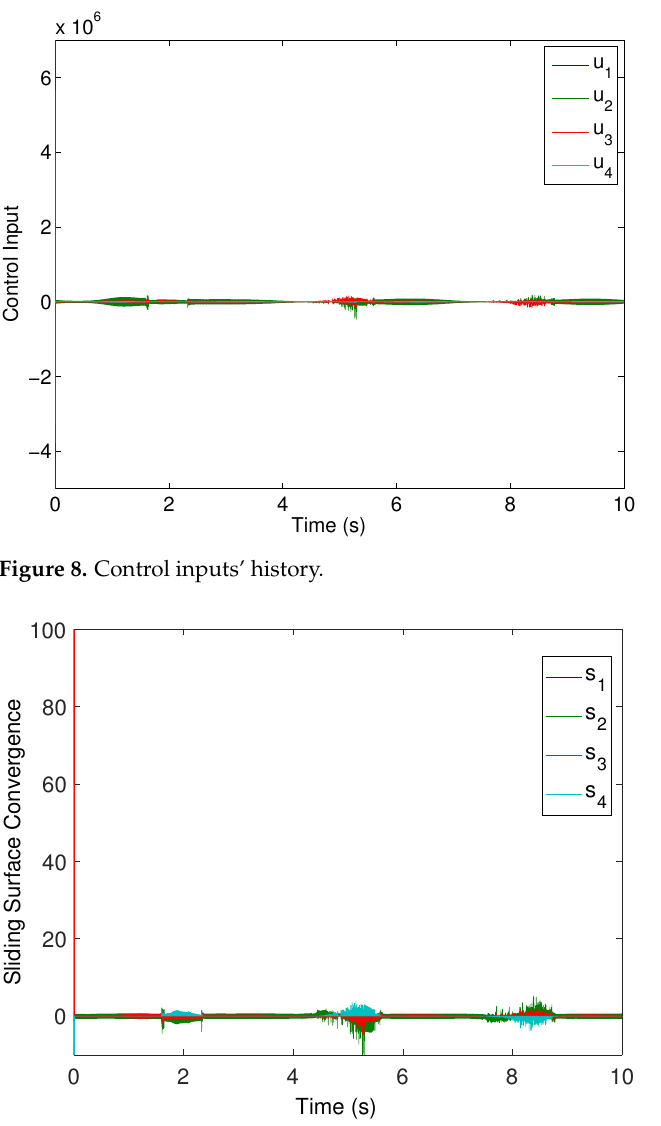
Figure 9. The sliding manifolds convergence from the very start